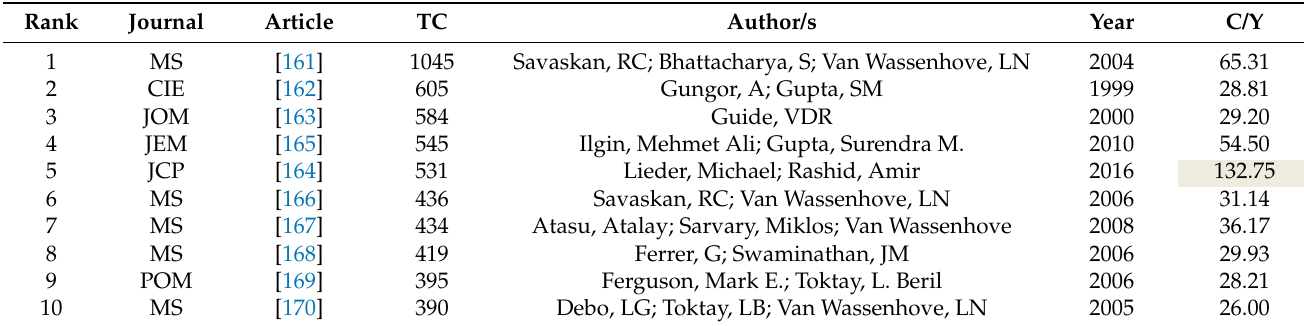
Table 5. Most influential articles on remanufacturing, based on WOS database.